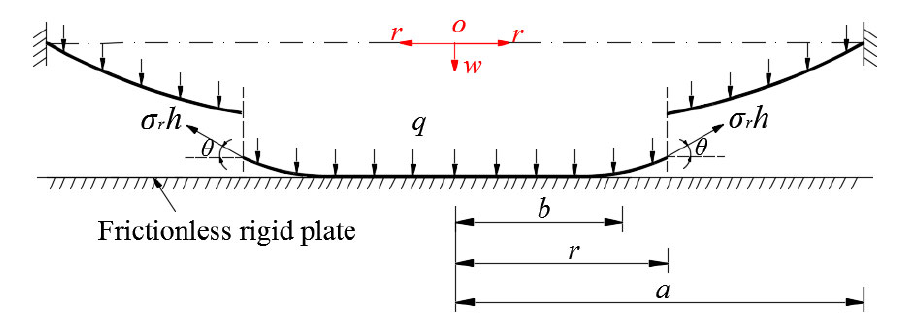
Figure 2. Equilibrium diagram of a free body with radius b ≤ r ≤ a .